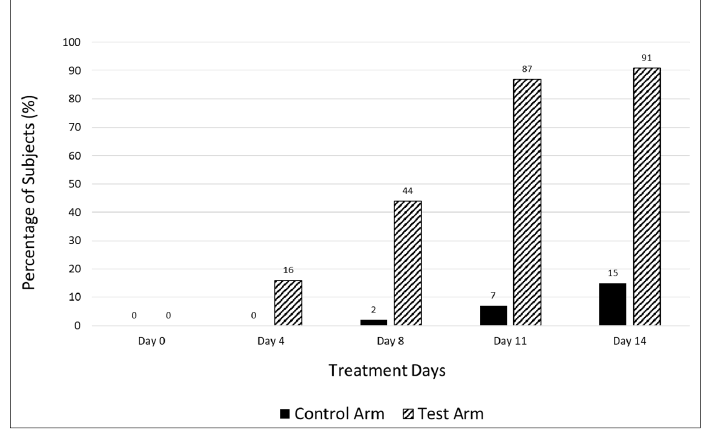
Figure 2. Percentage of fatigue-free subjects in the control and test arms at various time points dur- ing the treatment period.